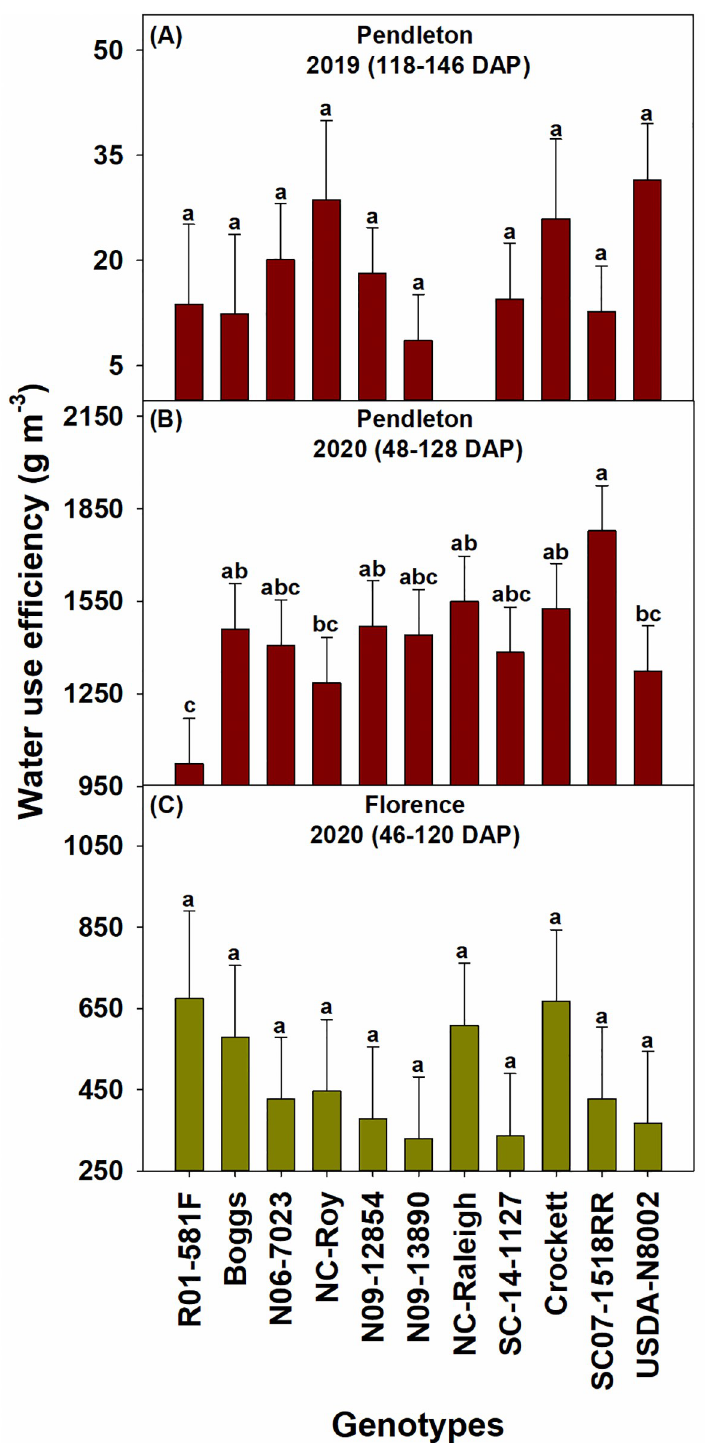
Fig 6. Water use efficiency of the soybean genotypes at Pendleton (A) in 2019 and 2020 (B) and Florence in 2020 (C). Water use efficiency was not measured at Florence in 2019. Least squares means with different letters are significantly different according to the Fisher’s least significant difference (LSD) test at α < 0.05. DAP–days after planting. Most genotypes reached V8 and R6 growth stages by 48 and 128 DAP, respectively, at Pendleton in 2020. Most genotypes reached V7 and R7 growth stages by 46 and 120 DAP, respectively, at Florence in 2020. Growth stages were determined following Fehr and Caviness [71]. https://doi.org/10.1371/journal.pone.0270109.g006 PLOS ONE | https://doi.org/10.1371/journal.pone.0270109 June 23,